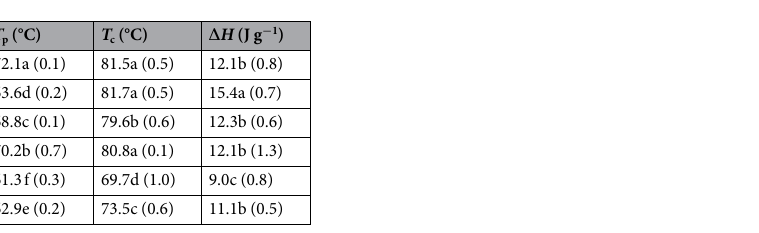
Hot paste viscosity (cP)